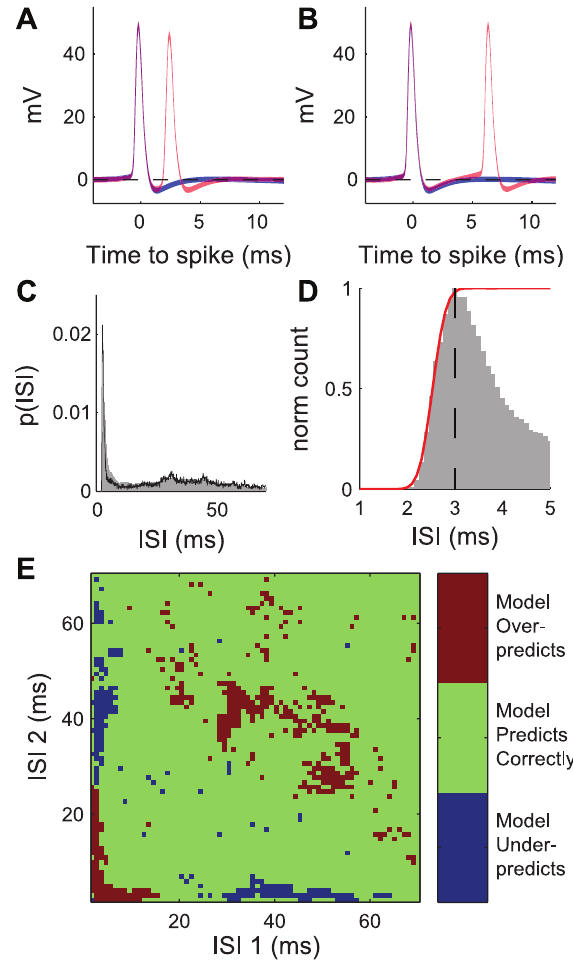
Figure 1. Statistics of doublet spiking. A: 6 1 SD envelope showing intracellular voltage waveform relative to resting membrane potential of isolated single spikes (blue) and isolated short doublets of ISI 2.6 ms (red) from a single recording in interneuron of class 10-2a. Dashed black line denotes mean resting membrane potential (0 mV). B: 6 1 SD of intracellular waveform from same recording as in A, this time with a doublet of ISI 6.5 ms (red, n=26). C: ISI histogram of data from recording in A and B at 0.1 ms resolution (black line, n=26,171 events), as well as compilation data from 40 cells of class 10-2a and 10-3a (gray shaded area, n=577,435 events). D: Normalized ISI histogram of population data from panel C, with time scale reduced to 1–5 ms. Red line shows the recovery function, with black dashed line showing limits of fit to recovery function. E: Difference between independent model and measurements from data of joint probability of consecutive ISIs. Positive (red) values represent overestimation by the independent model, while negative (blue) values represent underpredictions by the independent model.